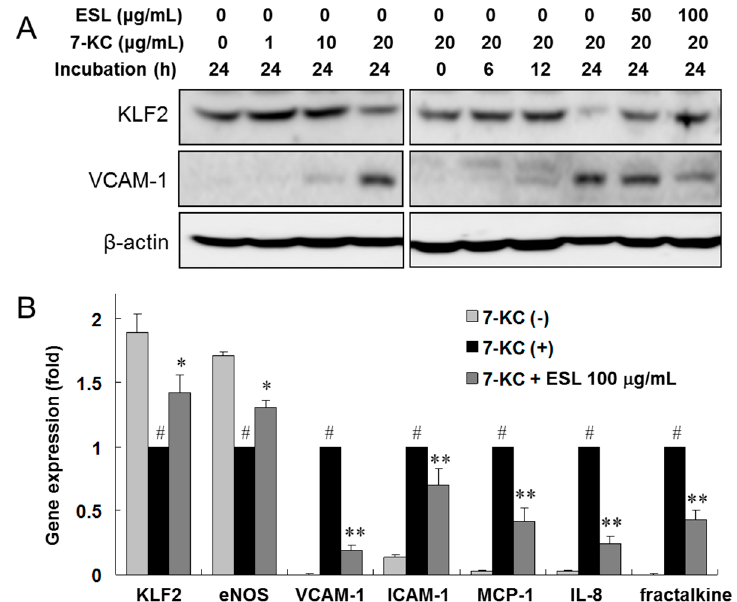
Figure 3. Cont Figure 3. Cont.